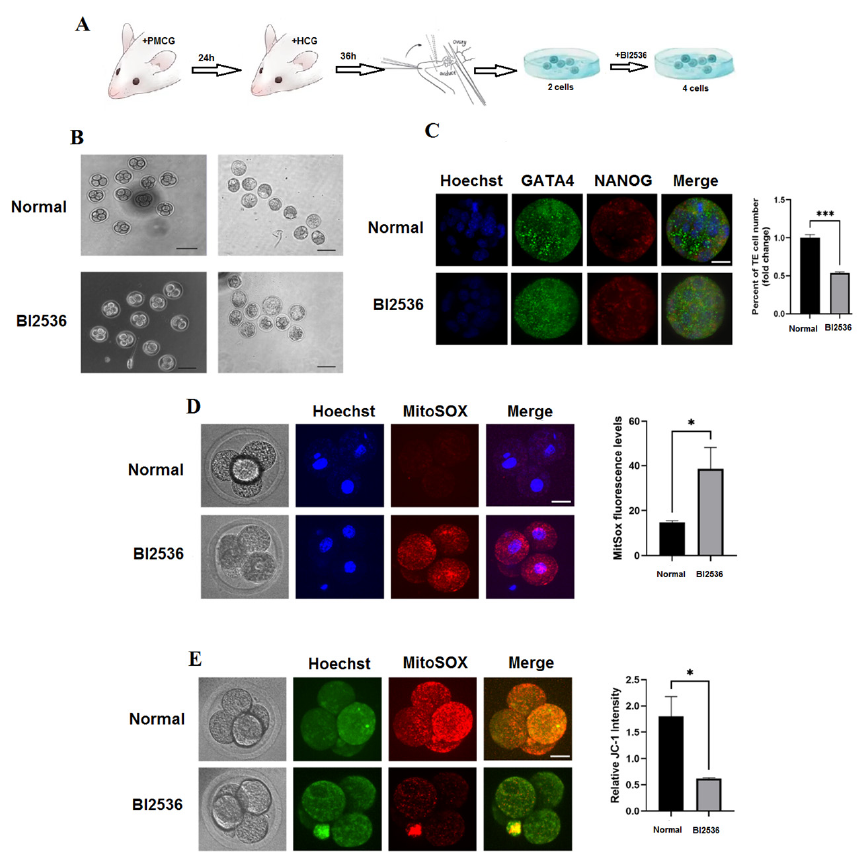
Figure 7. PLK1 inhibition affects the quality and potential for the development of pre-implantation embryos: ( A ) flowchart illustrating how embryos are collected; ( B ) the PLK1 inhibitor limited the growth of blastocysts and four-cell embryos; ( C ) total ICM staining, Hoechst nucleus/DNA staining, NANOG staining, and GATA4 primitive endoderm staining (GATA4 and NANOG merged); ( D ) how BI2536 affects the mitochondrial superoxide concentrations in mice four-cell embryos. To determine how BI2536 impacts mitochondrial potential, € mice four-cell embryos were stained with JC-1. Scale bar of 20 m. * p < 0.05, *** p < 0.001.